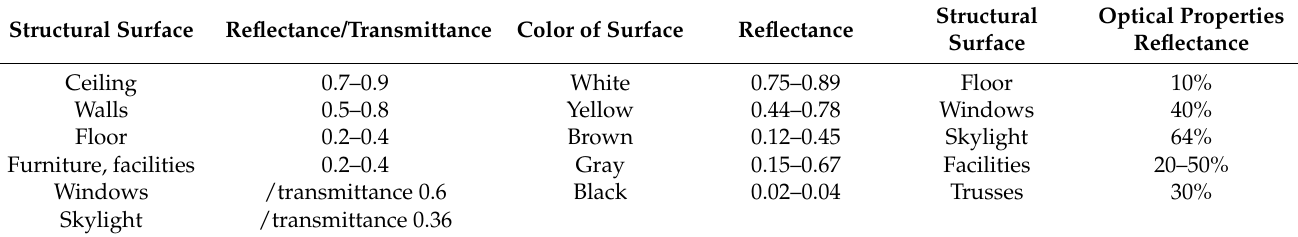
Figure 5. ( a ) ground floor—measured control points. ( b ) cross-section of selected hall building.